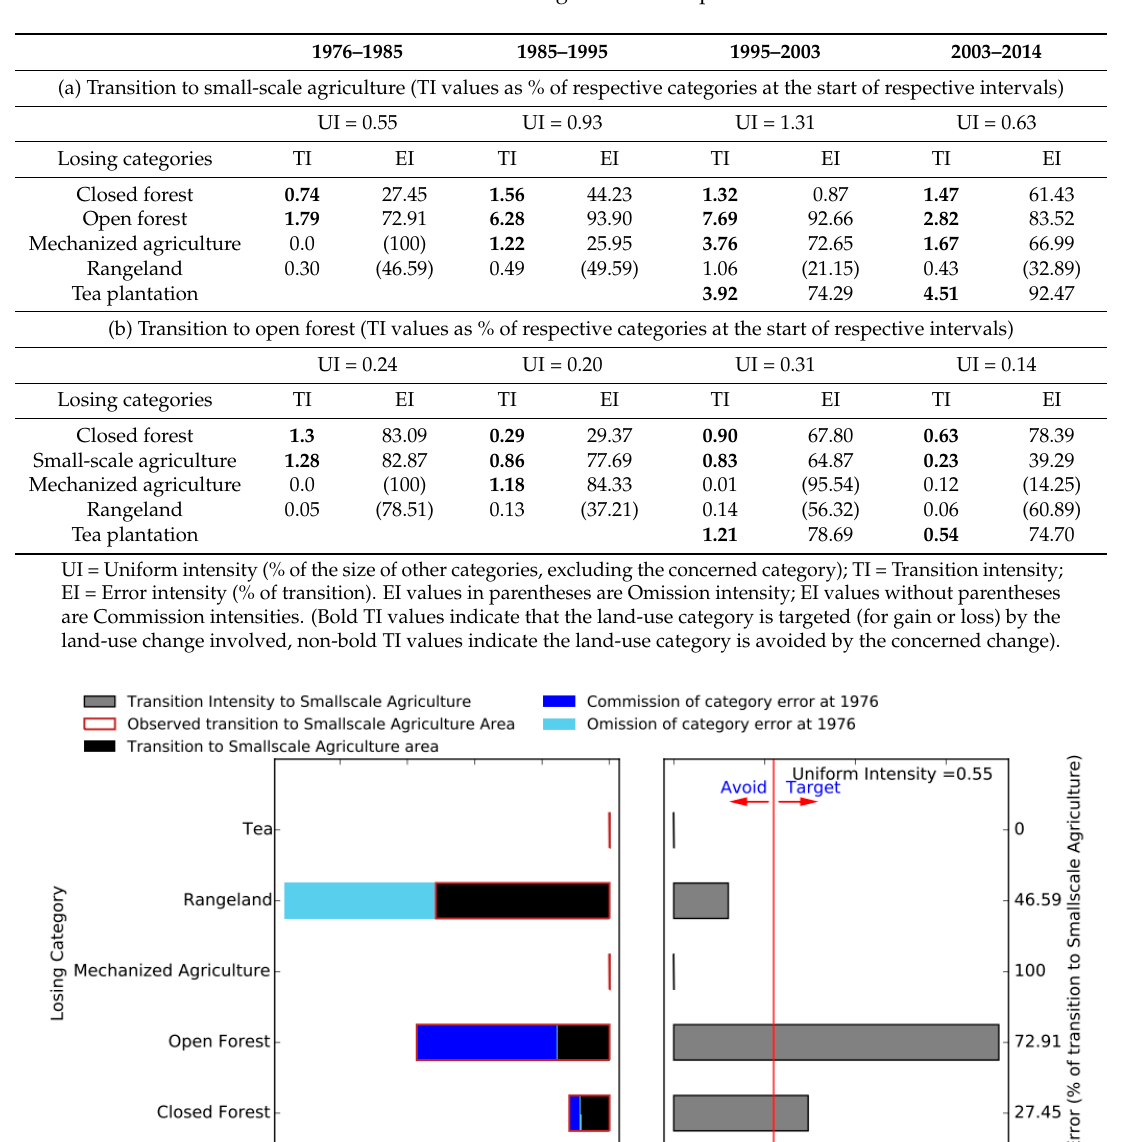
Table 2. Land-use transitions between categories with a special focus on deforestation.